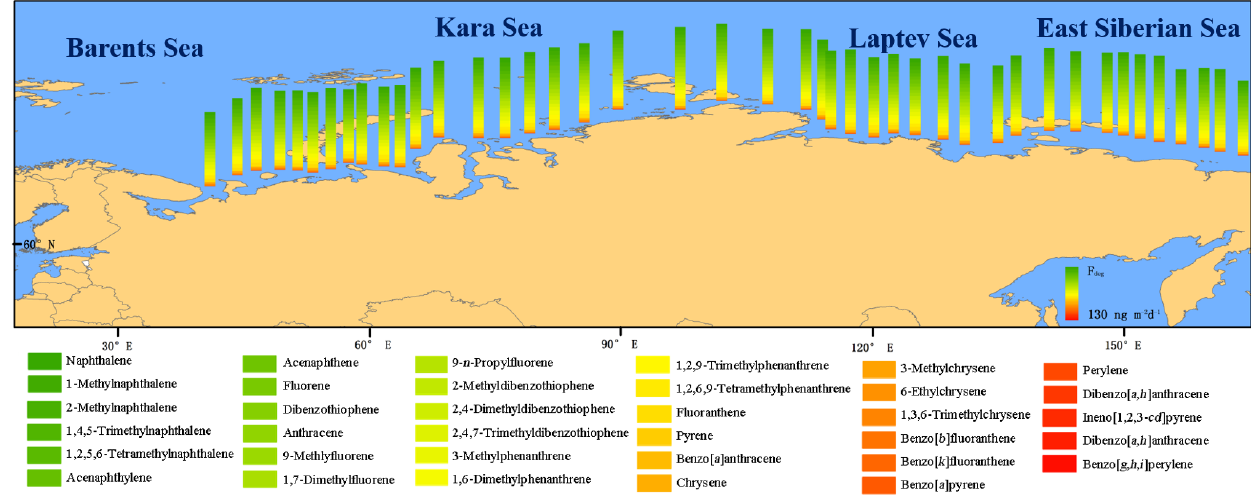
Figure 8. Atmospheric degradation of PAHs. Estimated fluxes of degraded PAHs in the gas phase following reaction with OH